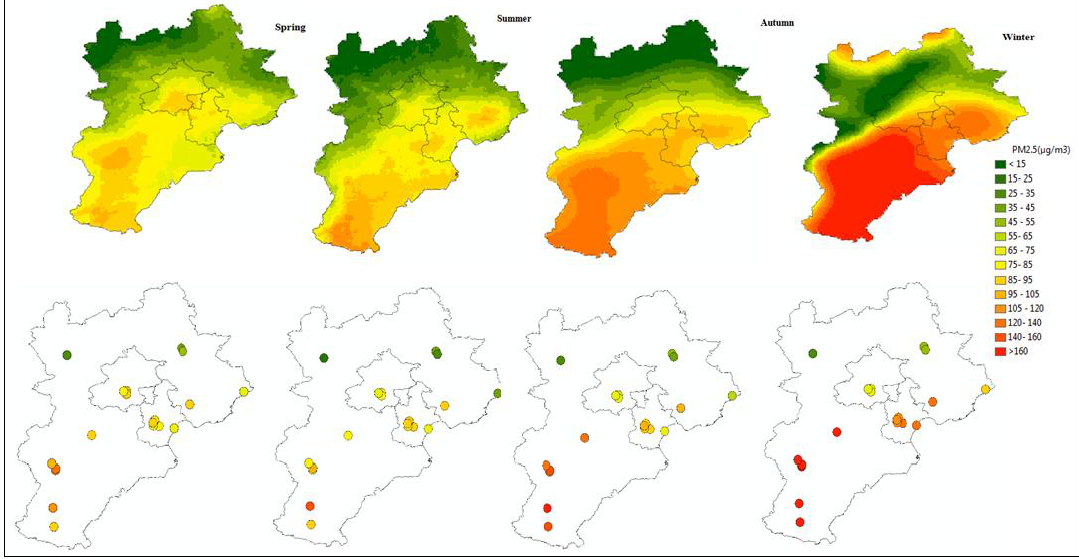
Figure 2. Spatial and temporal (seasonal) variation of PM 2.5 derived from GWR (upper) and comparison with ground observation (lower)